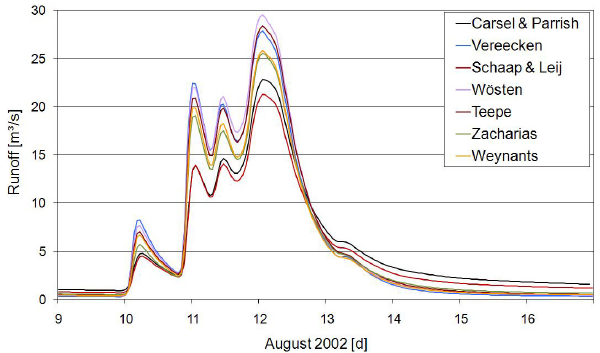
1 Figure 4: Different pedotransfer functions (e.g. SIL) 2 3 Fig. 4. Different pedotransfer functions (e.g. SIL). 4